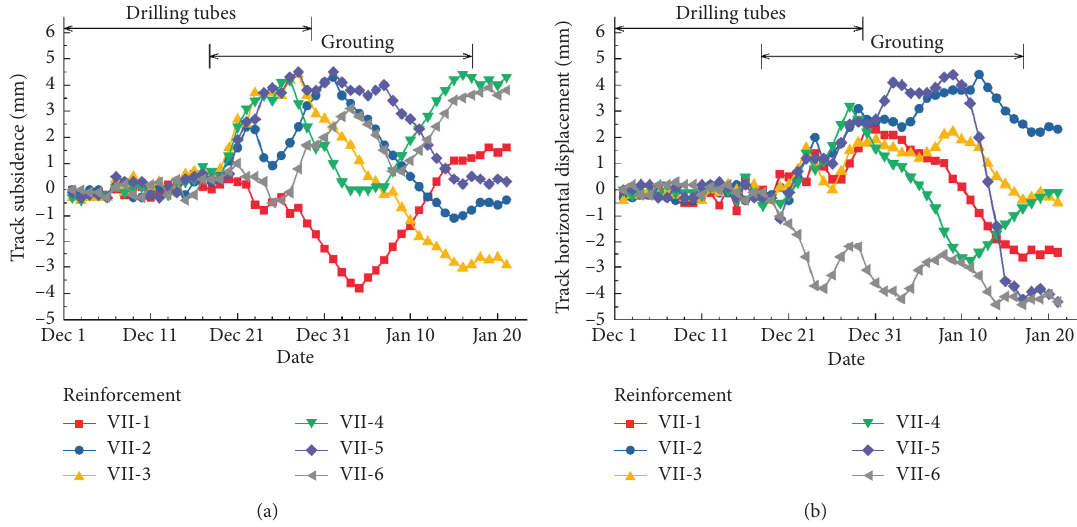
Figure 11: Monitored track displacement during ground improvement. (a) Track subsidence. (b) Horizontal track displacement.